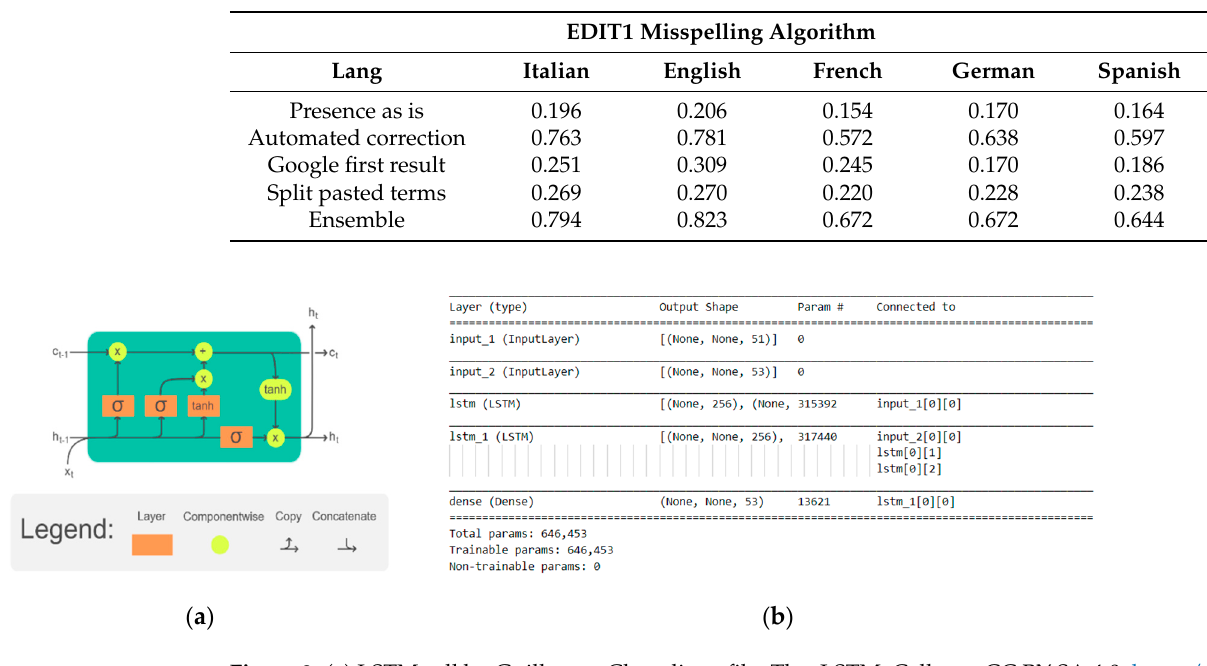
Figure 3. ( a ) LSTM cell by Guillaume Chevalier—file: The_LSTM_Cell.svg, CC BY-SA